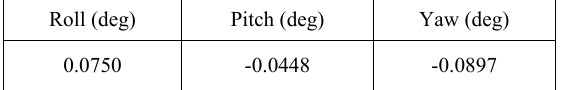
Table 7. Boresight